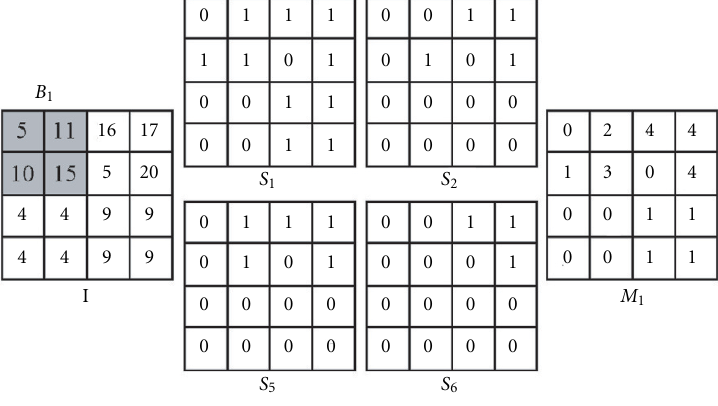
Figure 6: Example of slices and metaslice for a 4 × 4 image using blocks of 2 ×